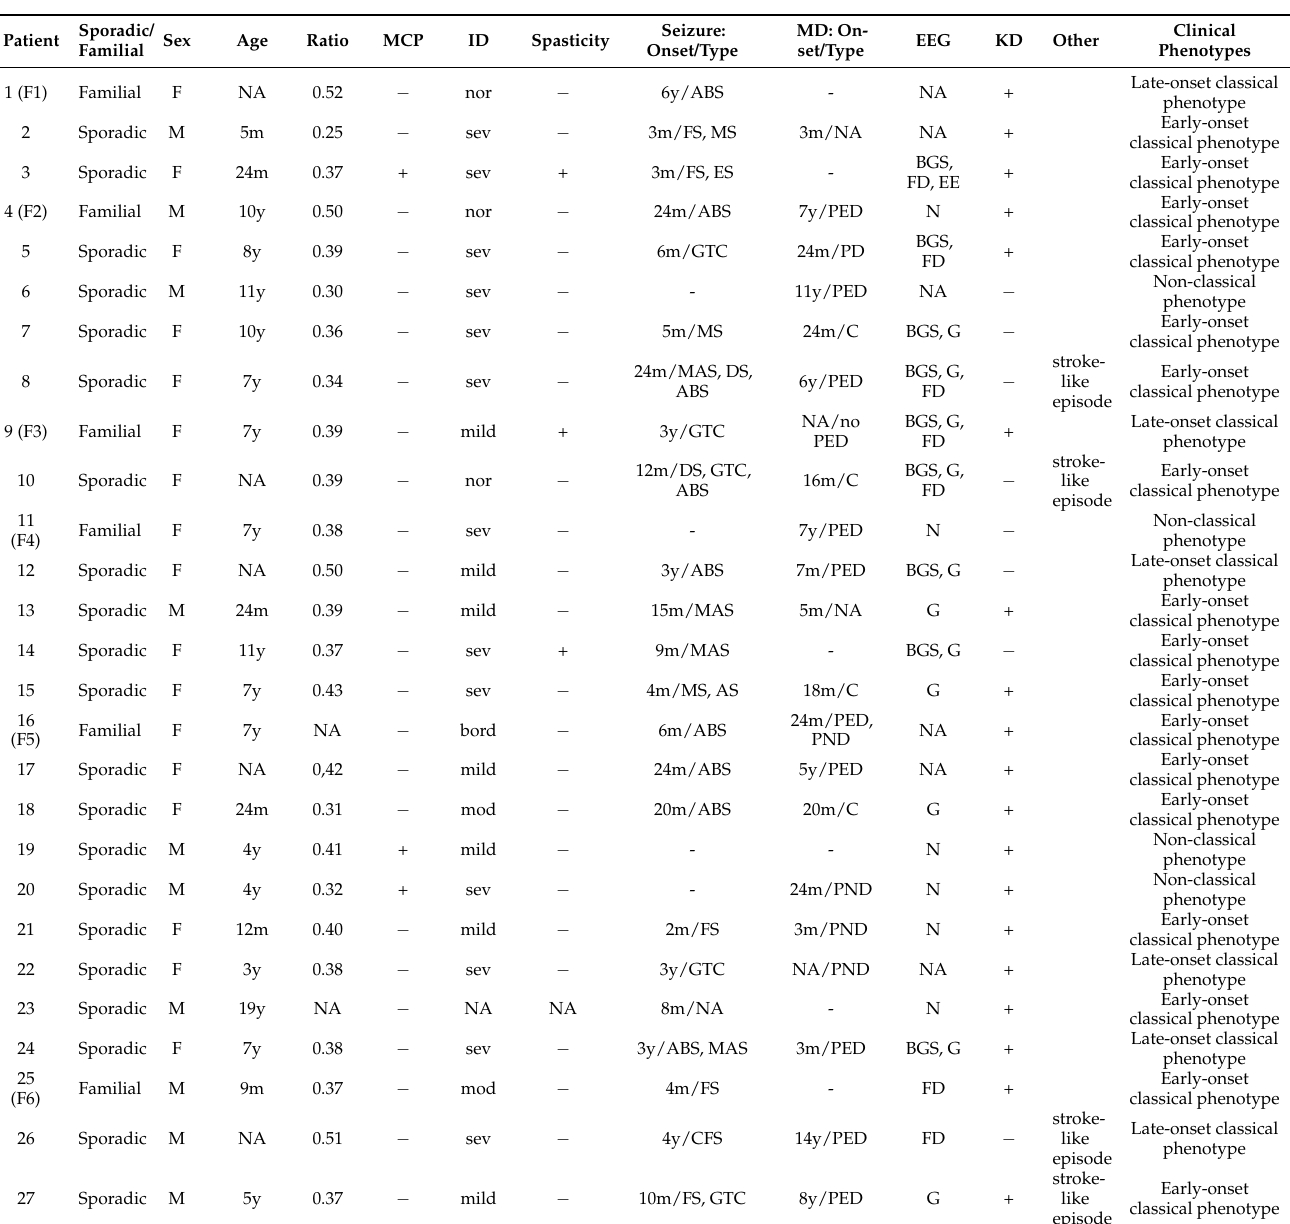
Table 1. Clinical and biochemical data observed in the GLUT1DS Italian patients. Abbreviations: F, female; M, male; Age, age of diagnosis; Ratio, CSF/blood glucose ratio; NA, not available; +, yes; − , no; MCP, microcephaly; m, months; y, years; sev, severe; mod, moderate; ABS, absence seizure; CFS, complex febrile seizures; DS, dyscognitive seizures; EE, epileptic encephalopathy; ES, epileptic spasms; FS, focal seizures; GTC, generalized tonic-clonic seizures; MAS, myoclonic absence seizures; MS, myoclonic seizures; MD, movement disorder; C, chronic; PED, paroxysmal exertion-induced dyskinesia; PND, paroxysmal non exertion-induced dyskinesia; FD, focal discharges; G,